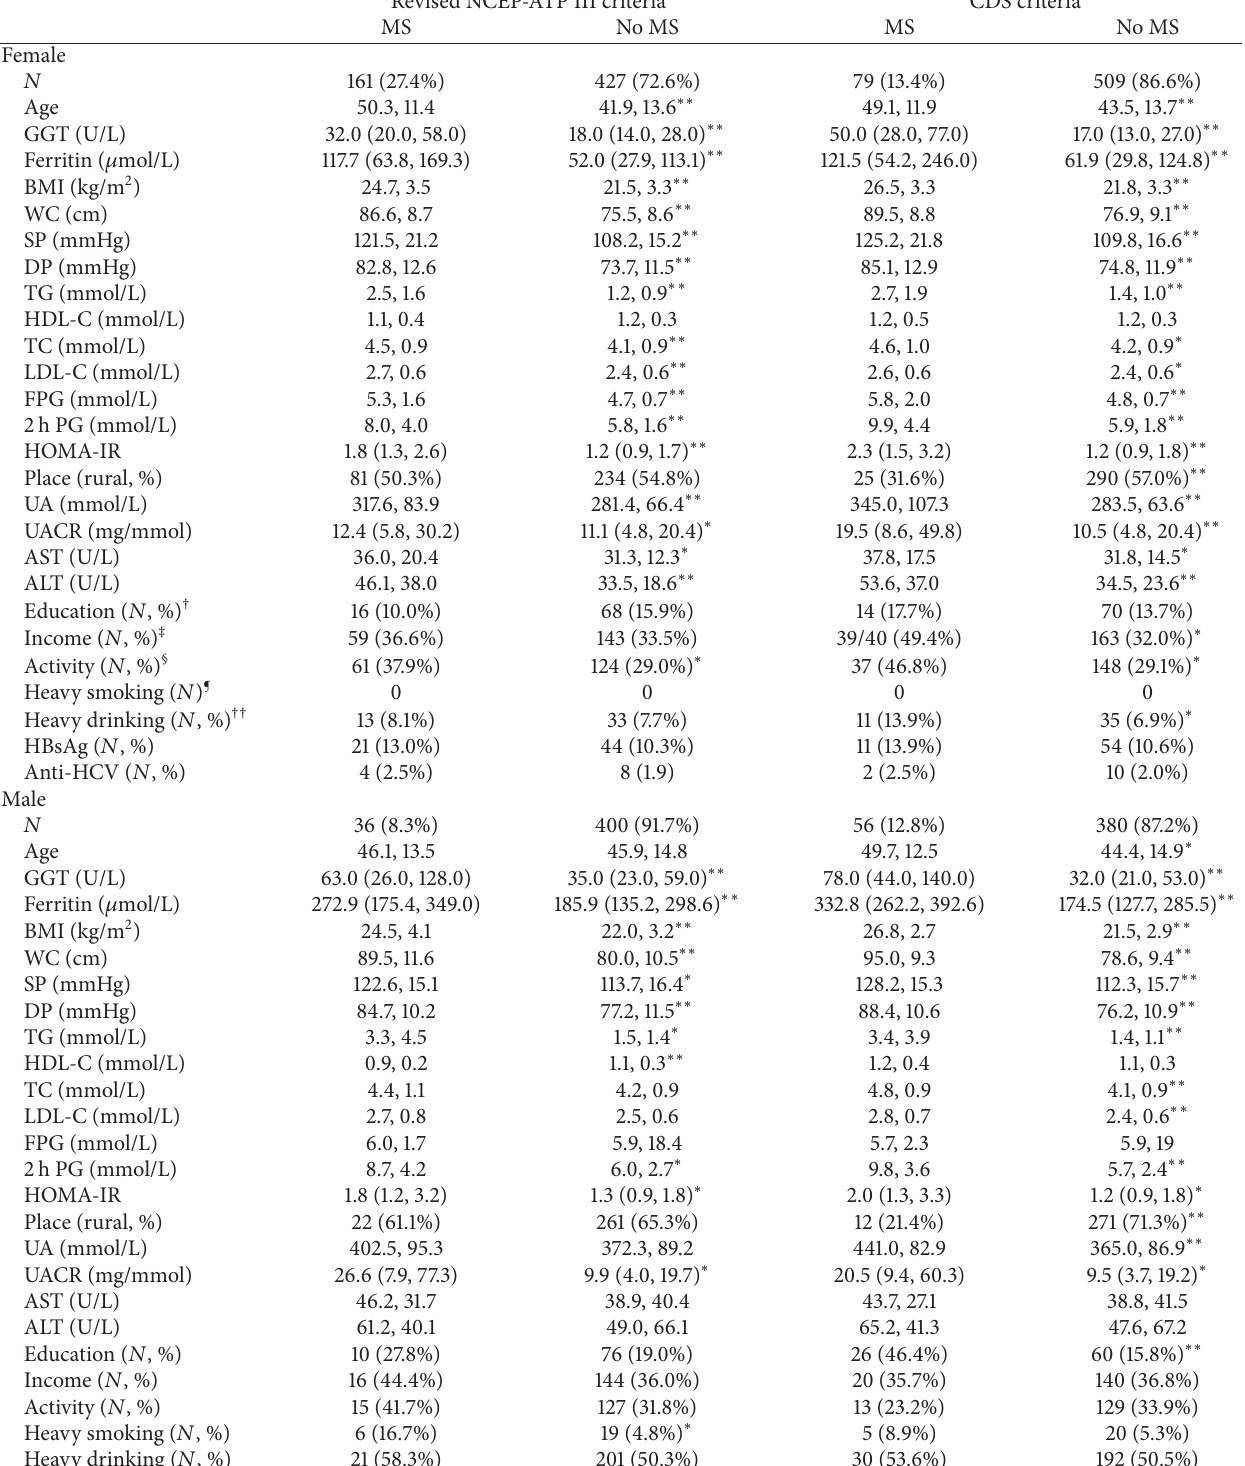
Table 1: Clinical and laboratory characteristics of subjects with and without metabolic syndrome according to the revised NCEP-ATP III and CDS